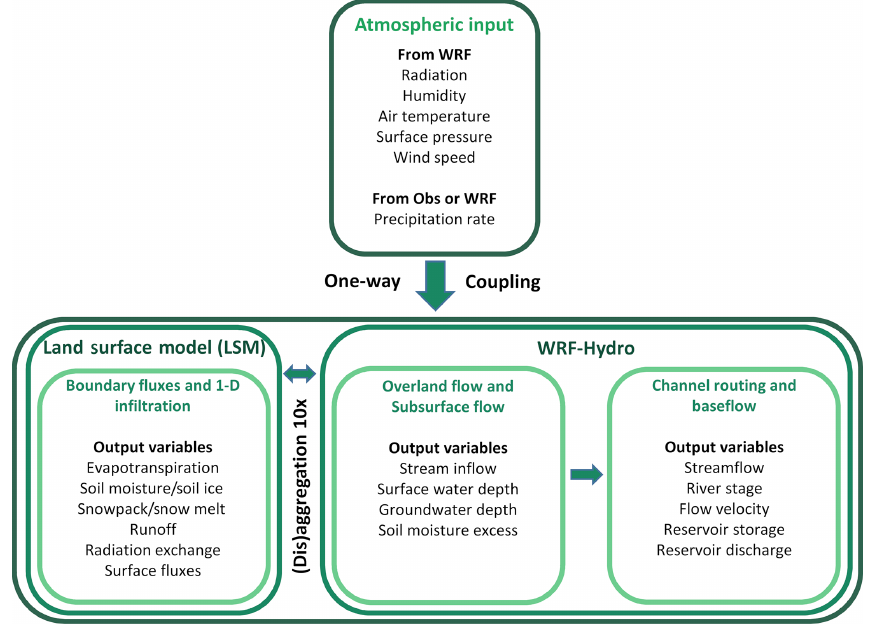
Figure 2. Schematic illustration of the model structure used in this study, including the coupling between WRF, the Noah Land Surface Model and WRF-Hydro routines (modified after Gochis et al.,